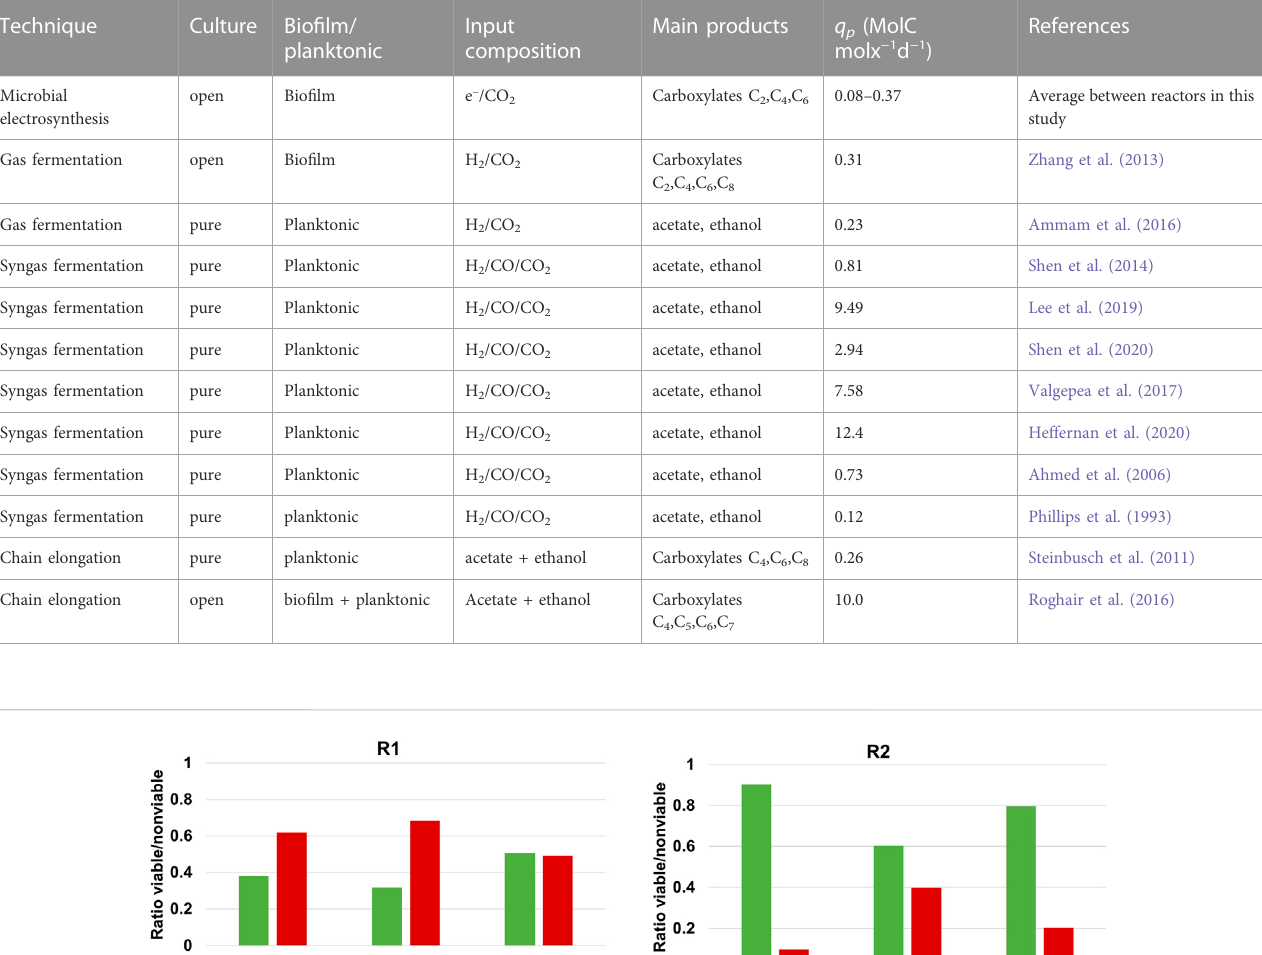
TABLE2ComparisonofreactorperformancewithSyngasfermentationandChainelongationfermentation.Forstudiesnormalizingbiomasstodrycellweight(DCW),a molecular weight of 25.25 g mol − 1 was used for biomass. For studies normalizing biomass to volatile suspended solids (VSS) it was assumed that 1 gVSS equals 1 gDCW. C